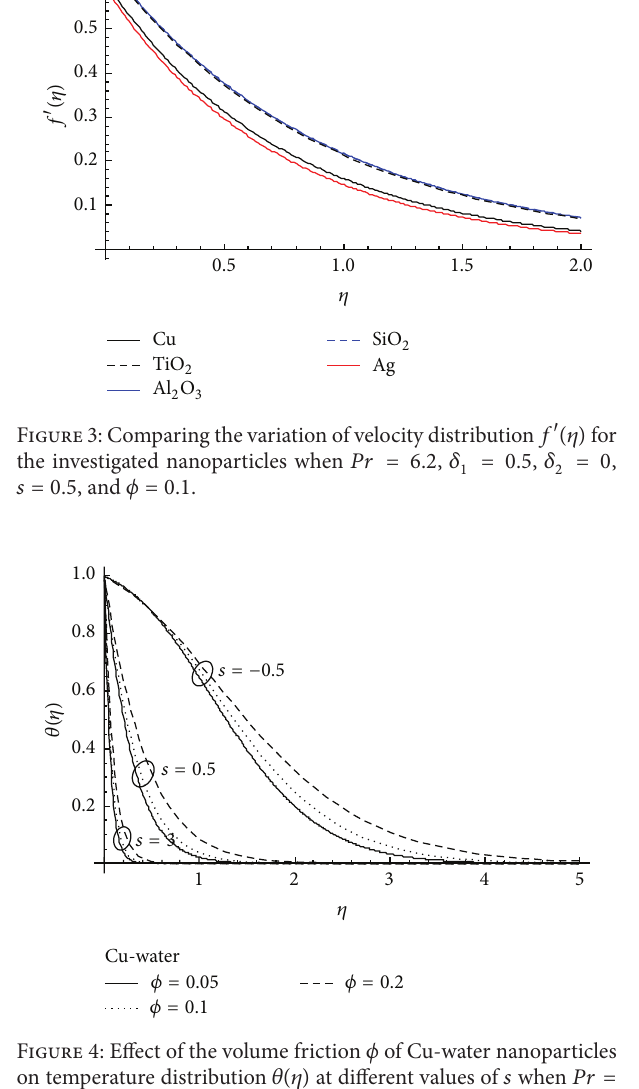
Figure 2: Effect of the volume friction 𝜙 of Al 2 O 3 -water nanopar- ticles on velocity distribution 𝑓 󸀠 (𝜂) at different values of 𝑠 when = 1 , and 𝛿 = 0 . 𝑃𝑟 = 6.2 , 𝛿 1 2